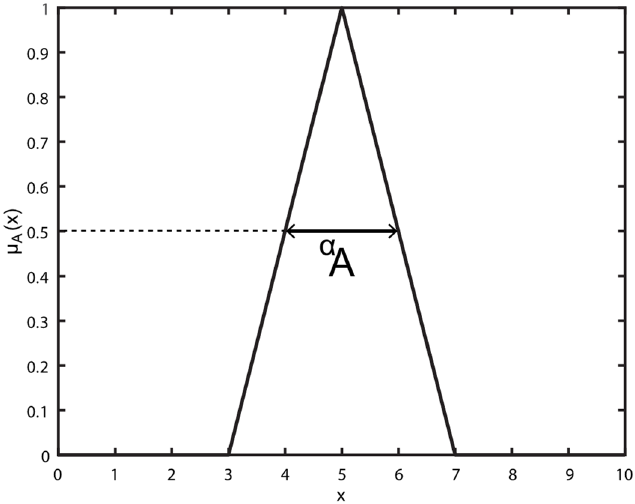
Figure 1. Fuzzy numbers and their α-cut.